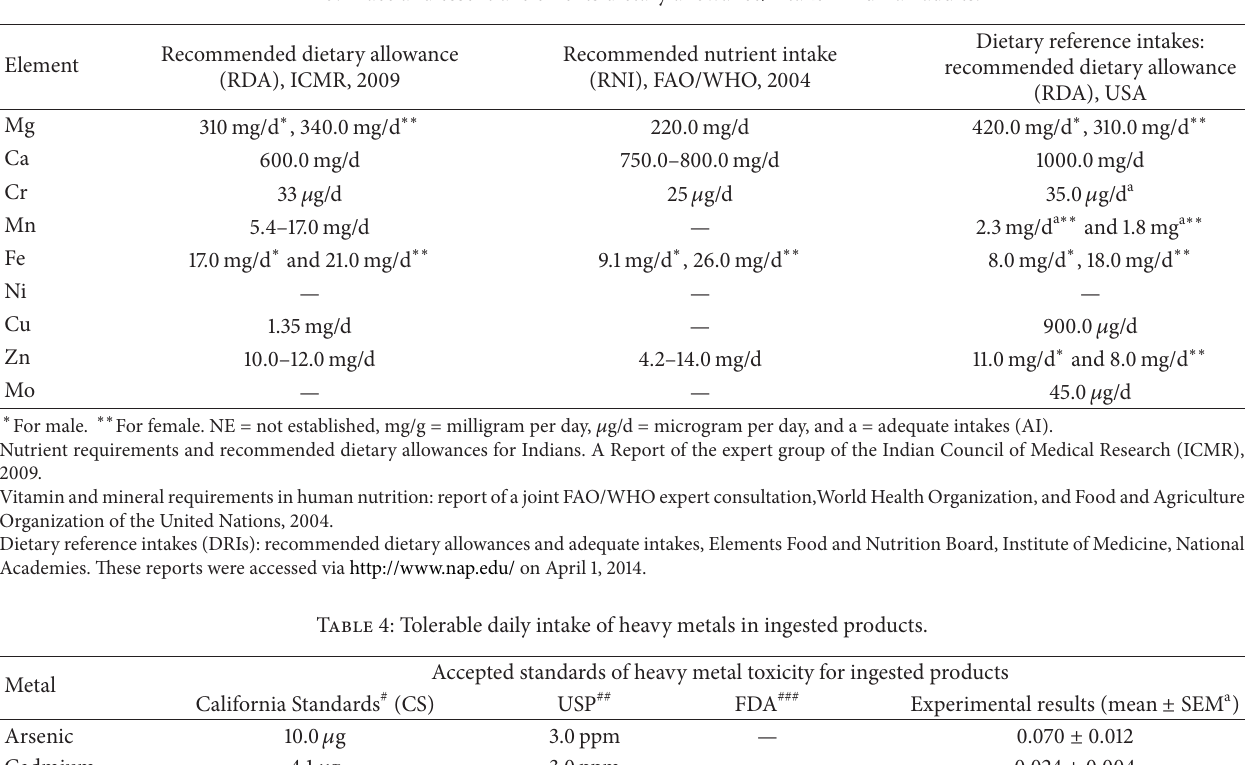
Table 3: Trace and essential elements dietary allowance/intake in human adults.